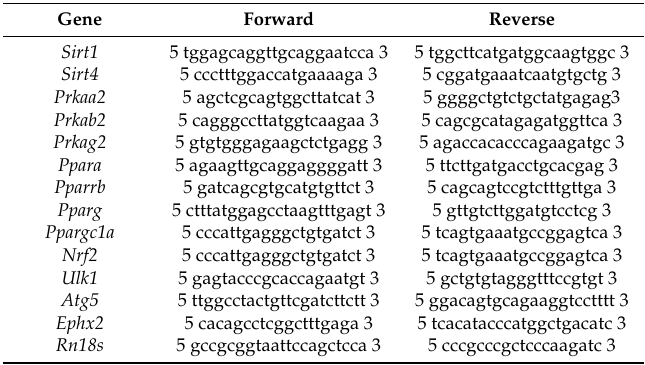
Table 1. Quantitative real-time polymerase chain reaction primers